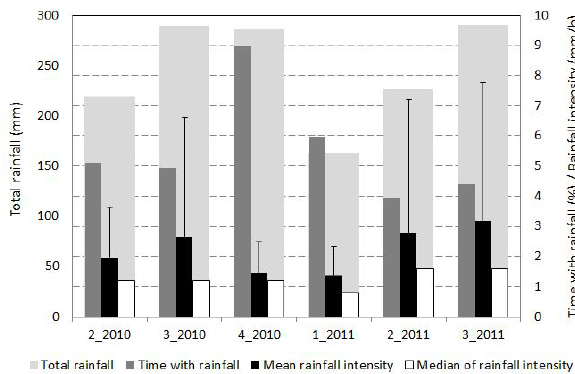
Fig. 2. Rainfall characteristics per season: total rainfall, percentage of time with rainfall, mean rainfall intensity (standard deviation denoted as error bars), and median of rainfall intensity.